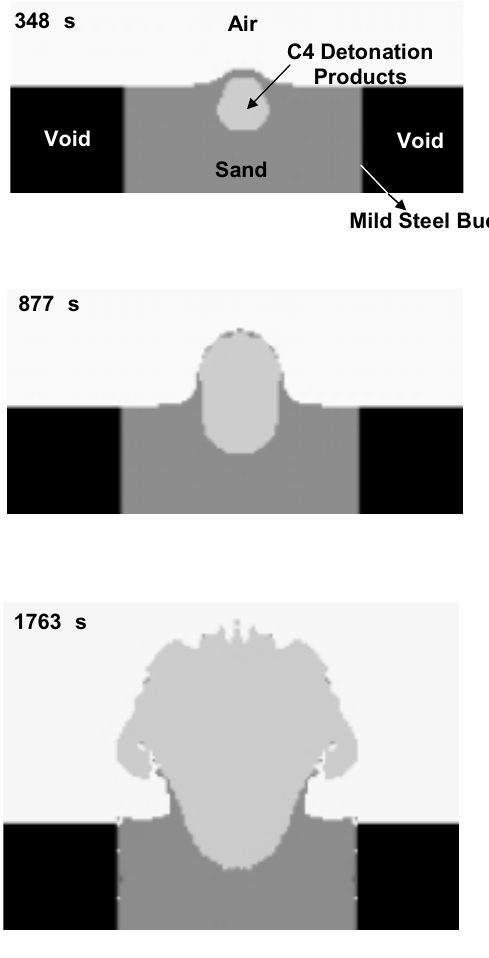
Fig. 6. Temporal evolution of material deformation in the case of landmine detonation (DOB = 8 cm) in the case of dry